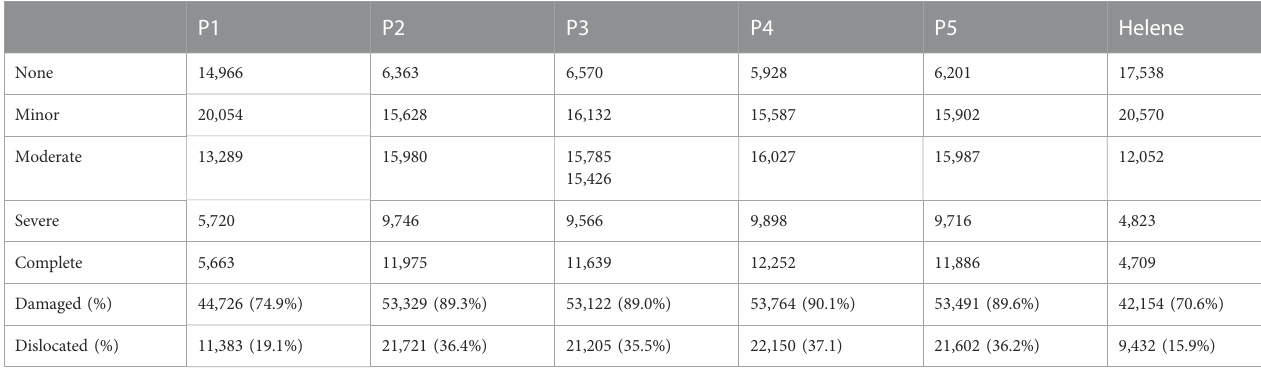
TABLE 2 Building damage summary for the 59,692 buildings in Onslow